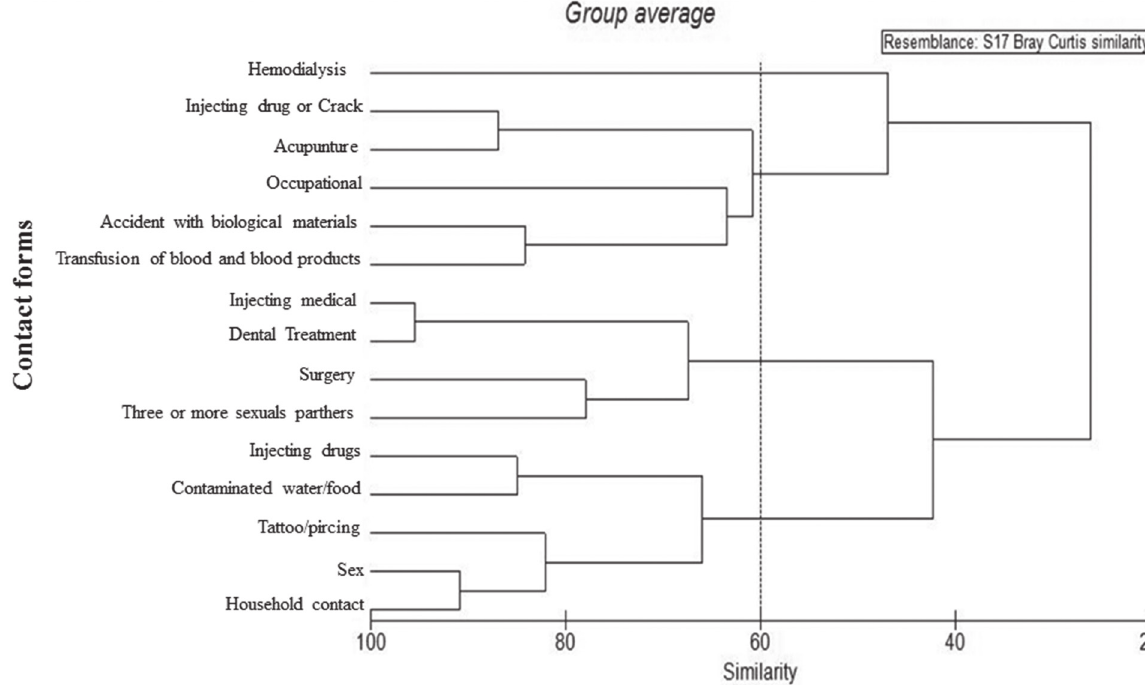
Figure 5 - Hierarchical Cluster Analysis - Dendrogram representing the contact forms of hepatitis in the cities of the Northern Region of the Espírito Santo and with timeline (2007-2013).